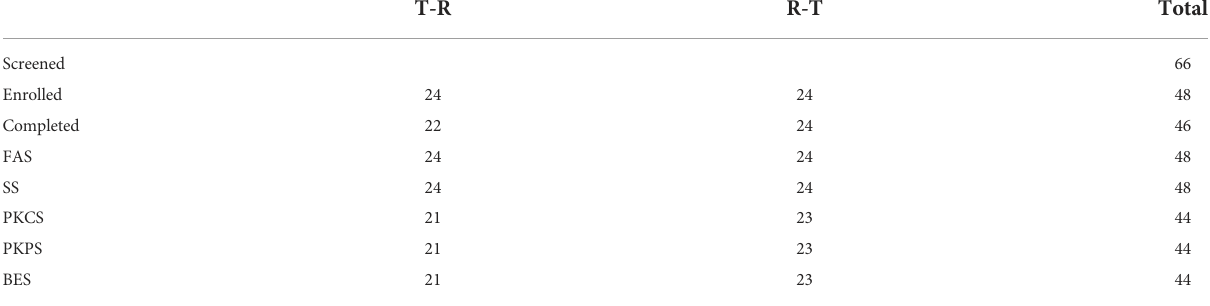
TABLE 2 Di fi nition of Analysis Data Sets.